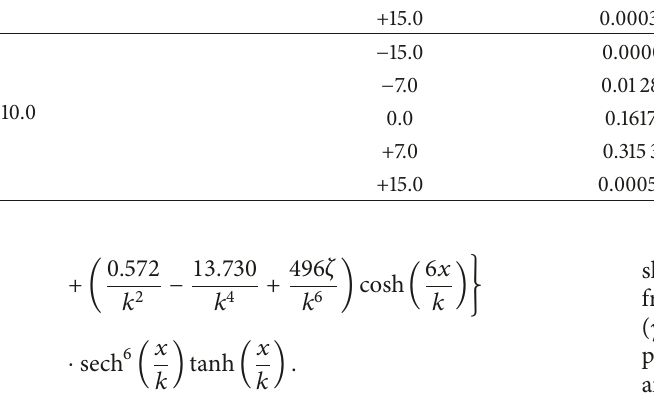
Table 2: Some values for numerical and exact solutions to the seventh order KdV equation expressed with the CFFD given in (5) at 𝑘 = 2.5 , 𝑑 = 4.0 , and 𝛾 = 1. Time ( 𝑡